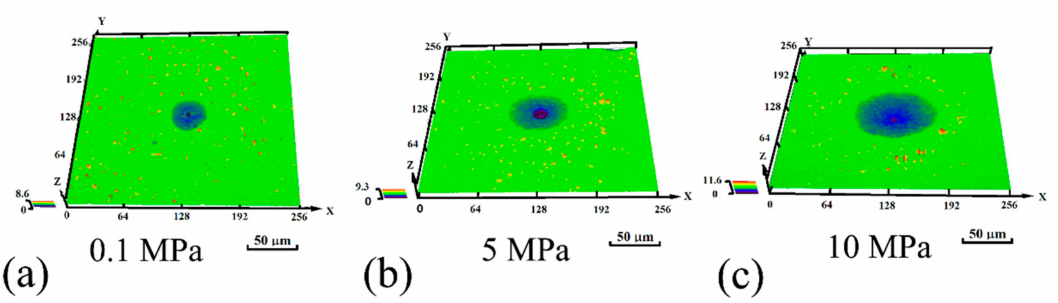
Figure 11. Typical 3D morphology of corrosion pits after immersion for 30 min in 0.1 mol/L NaCl solution at: ( a ) 0.1 MPa; ( b ) 5 MPa and ( c ) 10